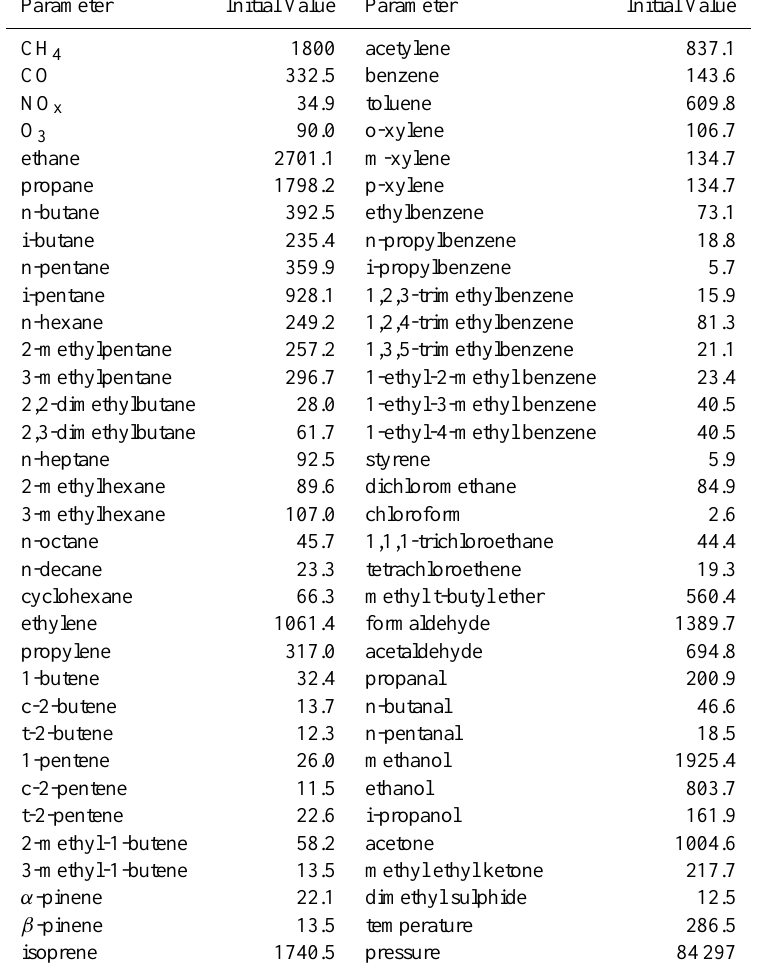
Table 1. Initial values of model parameters (CH 4 , CO, NO x and O 3 in ppbv, VOCs in pptv, temperature in K, pressure in